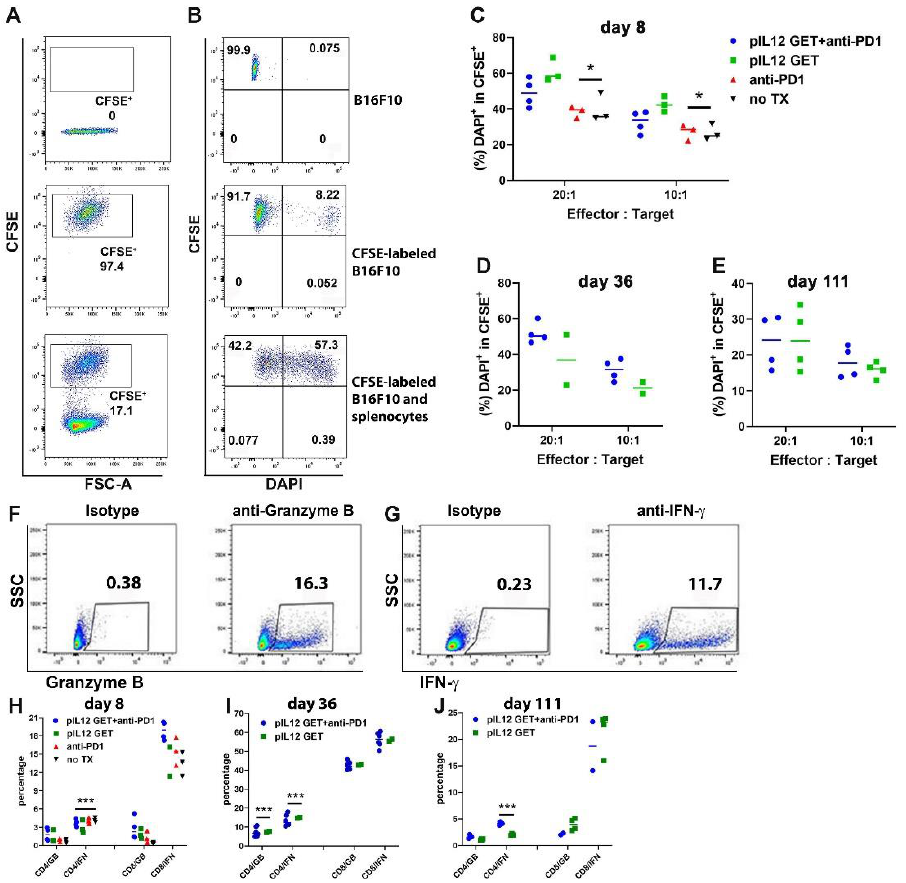
Figure 5. Combination therapy elicits T cells responses and is maintained for a long-term duration. On day 8, 36, 56, and 111, spleens were isolated from the mice (n = 5/group/experiment). After preparing single cells, splenocytes were cocultured at different ratios with CFSE-labeled B16F10 cell targets for 6 h. The cytotoxic activity of T cells was analyzed with FACS. ( A , B ) Representative FACS analysis of cytotoxicity of T cells. ( C – E ) Quantification of DAPI+/CFSE+ of the target population in comparison to the control population (CFSE-labeled B16F10 cells group). ( F , G ) Representative dot plots showing the gating strategy for granzyme B and IFN- γ . ( H – J ) Kinetics of IFN- γ or granzyme B production by CD8 and CD4 cells during days 8–111 after the onset of treatment. The experiments were performed three times, yielding similar results. * p < 0.05, *** p < 0.001. To further characterize the cytotoxicity of dominant cells, we sorted CD4 + and CD8 + T cells from the spleen of tumor-free mice on day 56 and examined the cytotoxic capacity